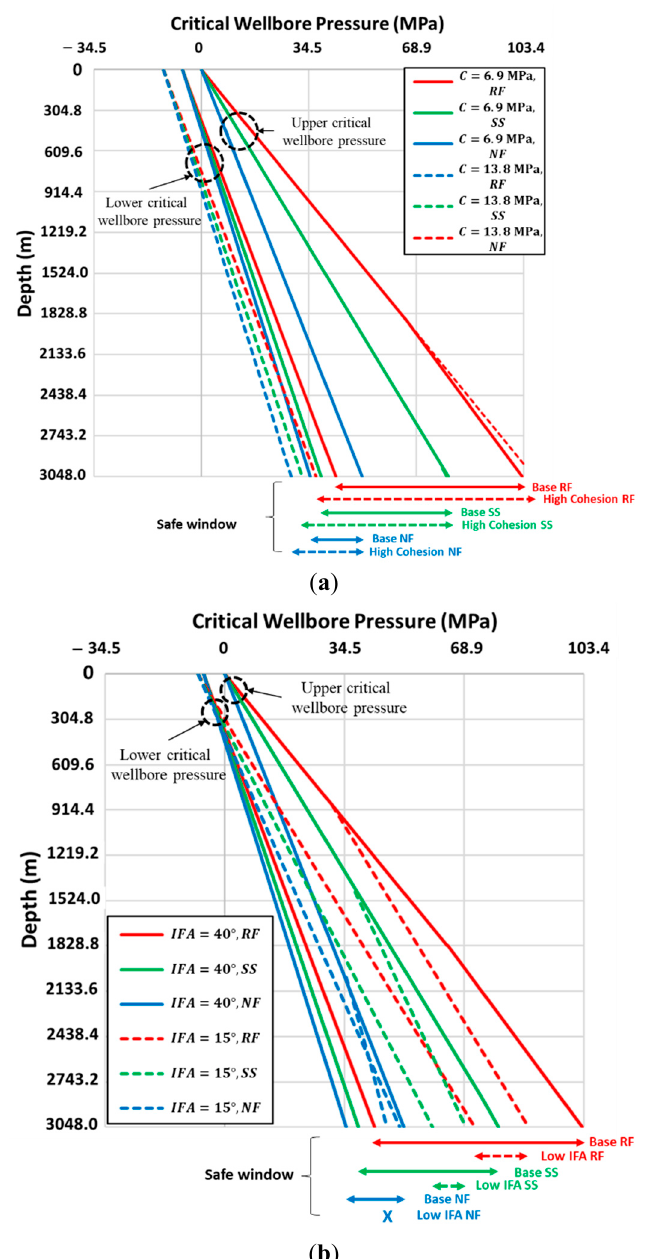
Figure 12. Comparison of the critical wellbore pressure calculated by the Mogi–Coulomb failure criterion. The dashed lines show the critical wellbore pressure with ( a ) the cohesion of 13.8 MPa and ( b ) the internal friction angle of 15°. The solid lines indicate the base case (the cohesion of 6.9 MPa and the internal friction angle of 40°). The colors represent the Andersonian cases, i.e., reverse faulting (RF; compressional basin; red), strike-slip (SS; green) and normal faulting (NF; extensional basin; blue). The arrows below the plots indicate the safe windows at 3048 m.